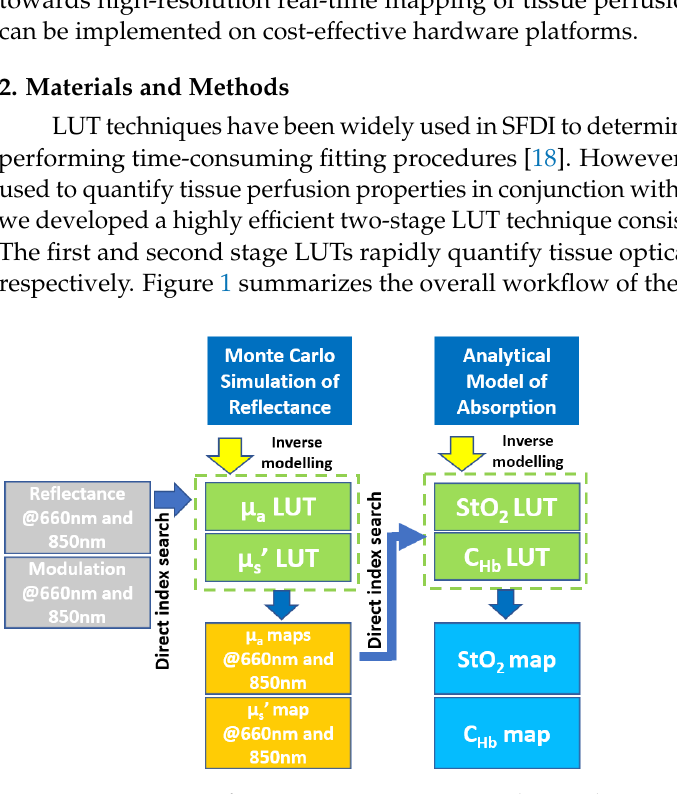
Figure 1. Overview of two-stage LUT. Monte Carlo simulation of reflectance and an analytical model of blood absorption are inverted to generate LUTs for optical property mapping (stage-1) and perfusion mapping (stage-2), respectively. SFDI measurements at 660 and 850 nm are used as inputs to quantify absorption and reduced scattering coefficients. The absorption coefficients are later used as search indices to quantify oxygen saturation and total hemoglobin concentration.